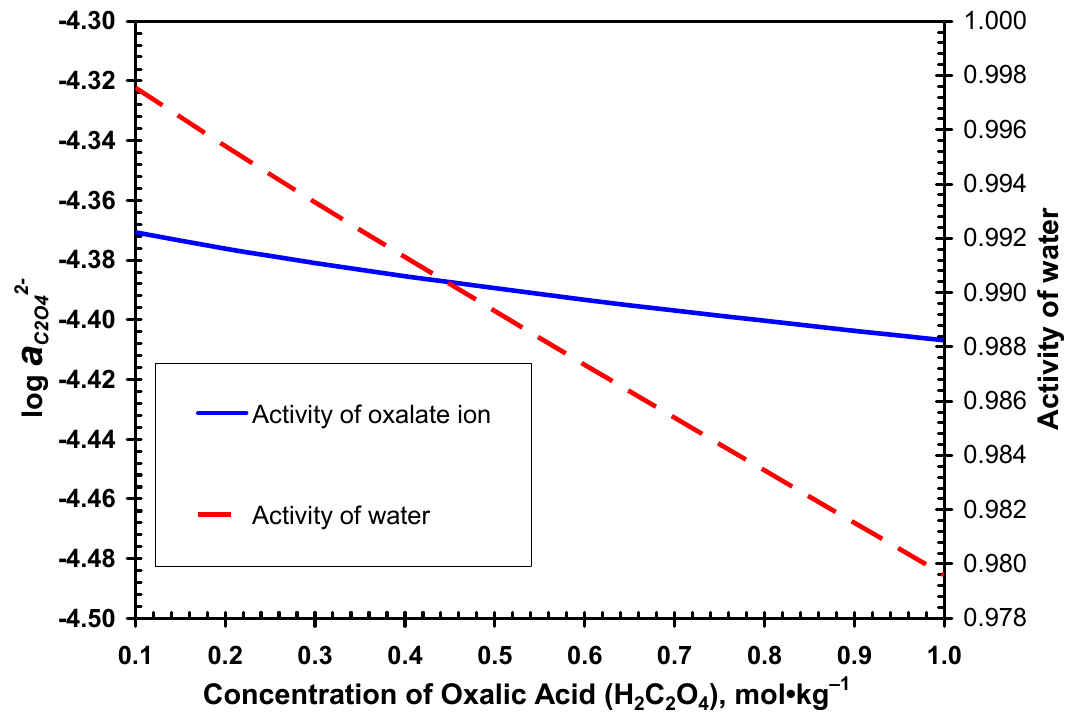
Figure 5. Predicted activities of oxalate species and water for oxalic acid (H 2 C 2 O 4 ) solutions relevant to desulphurization of lead sulfate in oxalate-bearing solutions at 25 °C and pH m = 1.0 (negative logarithm of hydrogen ion concentration on molal scale). Activities of oxalate species and water activities of oxalic acid solutions are calculated according to the thermodynamic parameters from Thakur et al. (2015), which are listed in Tables 1 and